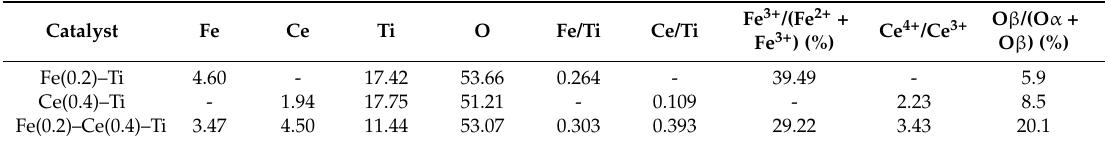
Figure 6. H 2 ‐ TPR profiles for Fe(0.2)–Ti and Fe(0.2)–Ce(0.4)–Ti catalysts. Table 2. XPS results of various catalysts. Table 2. XPS results of various catalysts.